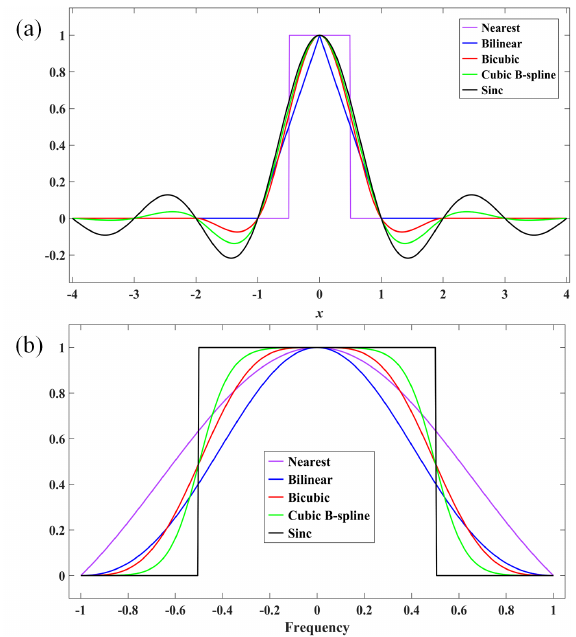
Figure 2a shows the interpolation kernels of different interpolation algorithms. It can be seen that cubic B-spline interpolator is closer to the ideal sinc function than others. The frequency responses of various kernels after Fourier transform are plotted in Figure 2b. The frequency analysis indicates the differences of frequency characteristics in both passband and stopband, which causes the different performance of four image interpolation algorithms in jitter detection and compensation.